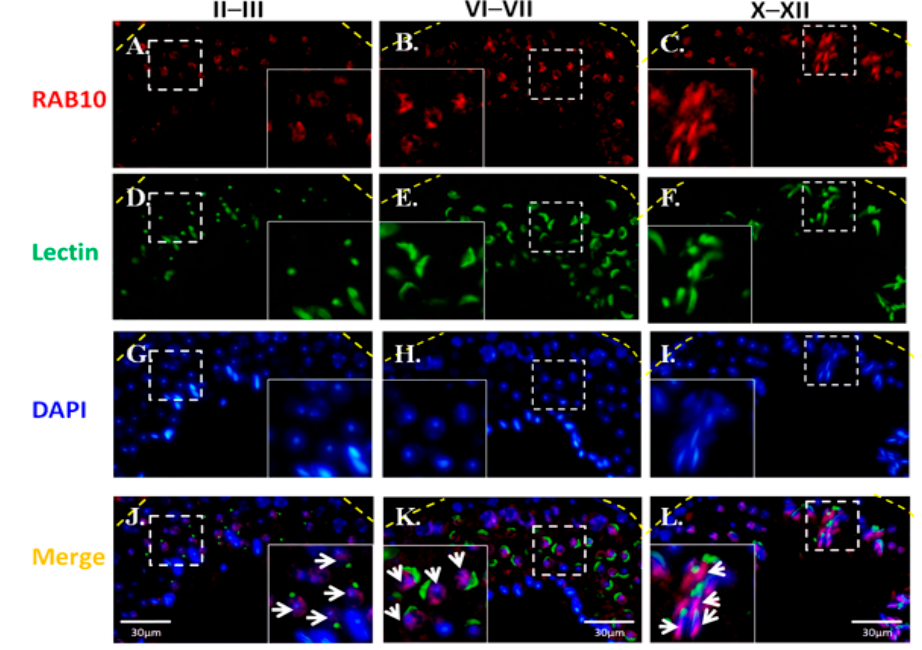
Figure 5. Expression patterns and localization of RBA10 during murine spermiogenesis; From left to right: stages II–III, stages VI–VII, and stage X–XII of spermatogenesis; ( A – C ), RAB10 signal (red); ( D – F ), Lectin (green, acrosome marker); ( G – I ), nuclear DNA (blue); ( J – L ), merge of RAB10, lectin, and nuclear DNA signals; The enlarged figures are shown in the right and left lower corners. The arrow indicates the RAB10 staining signals; DAPI: 4 ′ ,6-diamidino-2-phenylindole.